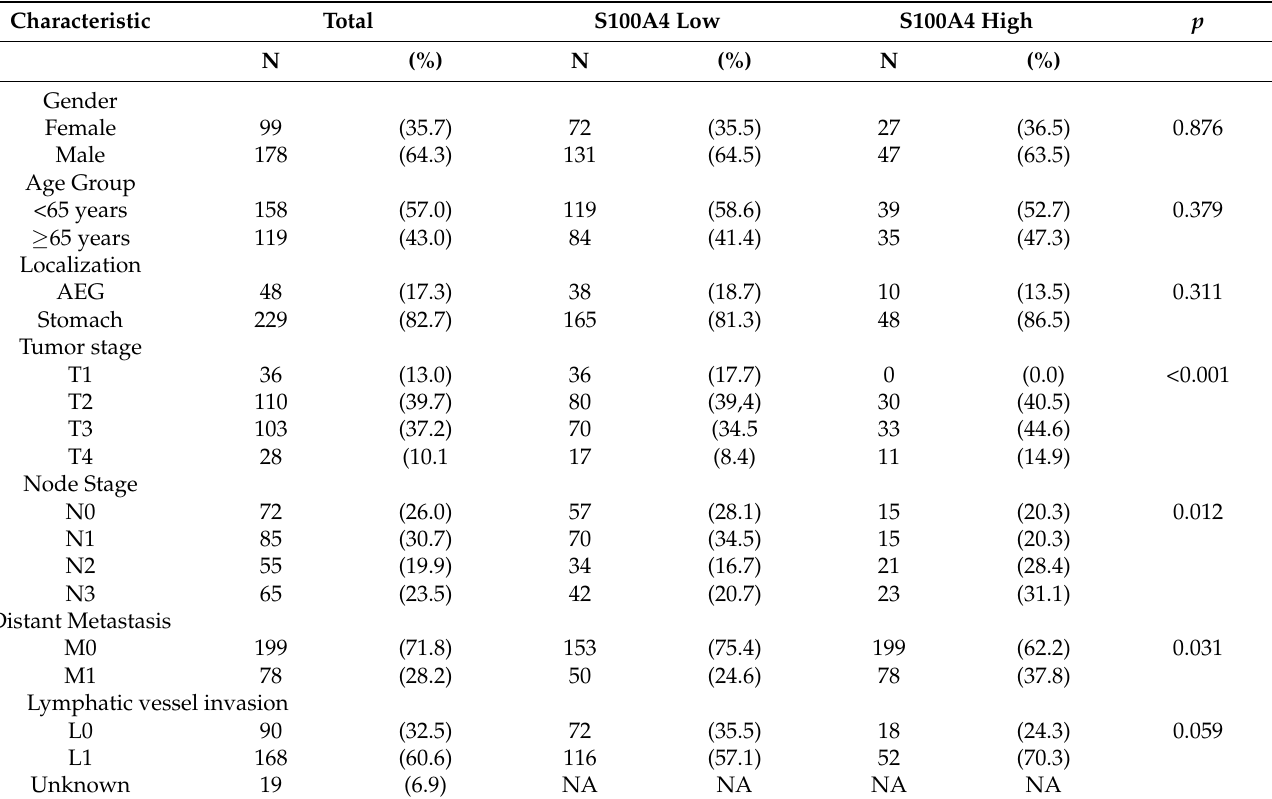
Table 2. Patient characteristics of the analyzed patient cohort and distribution of S100A4 high and low tumors. Significance calculated by